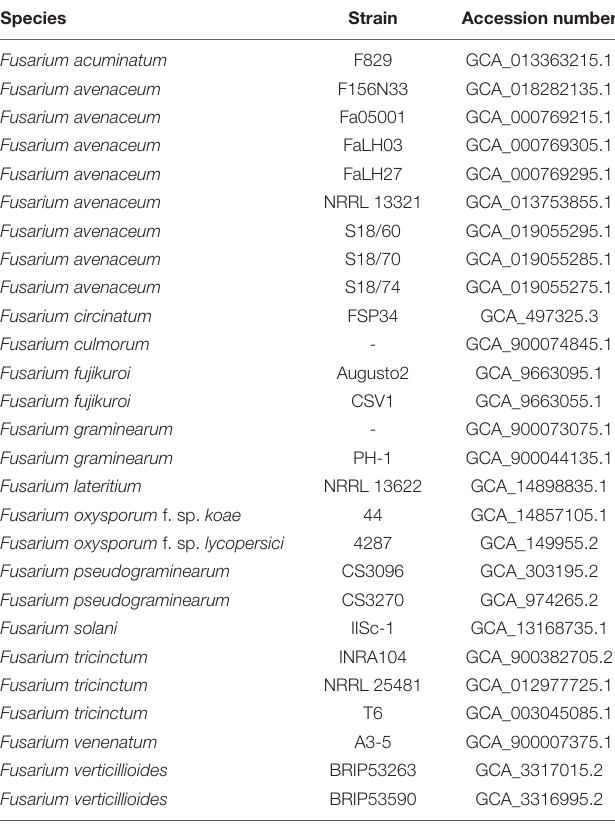
TABLE 1 | List of Fusarium species used for pairwise genome comparisons and phylogenetic analysis. Species